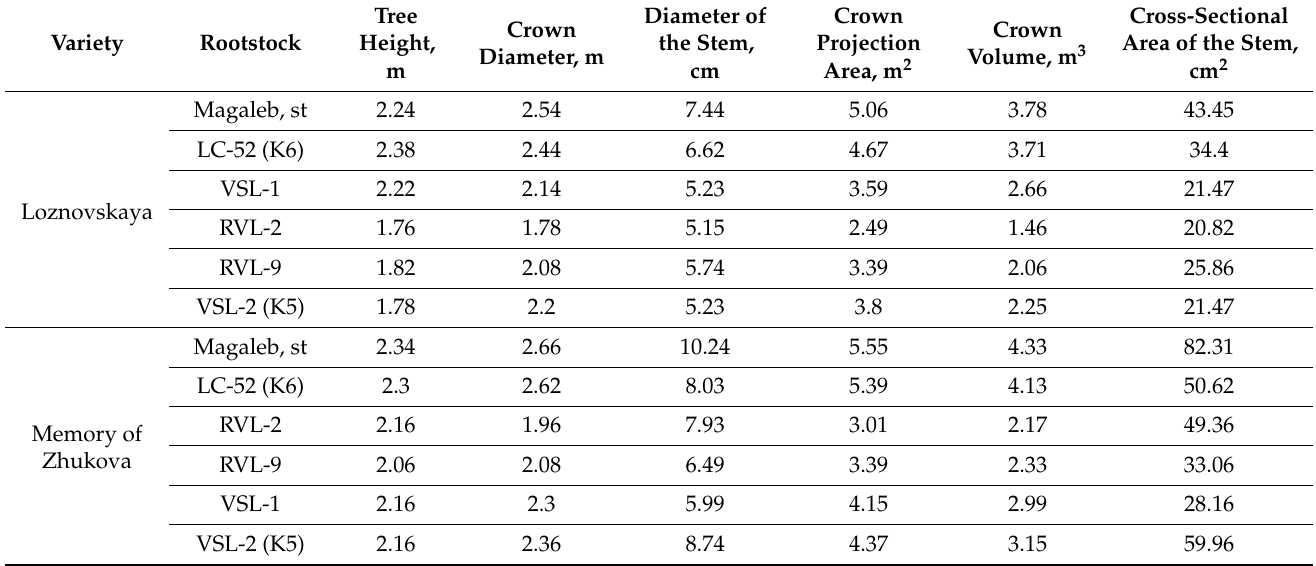
Table 4. Biometric indicators of cherry cultivar − rootstock combinations, (2019 − 2021 years).